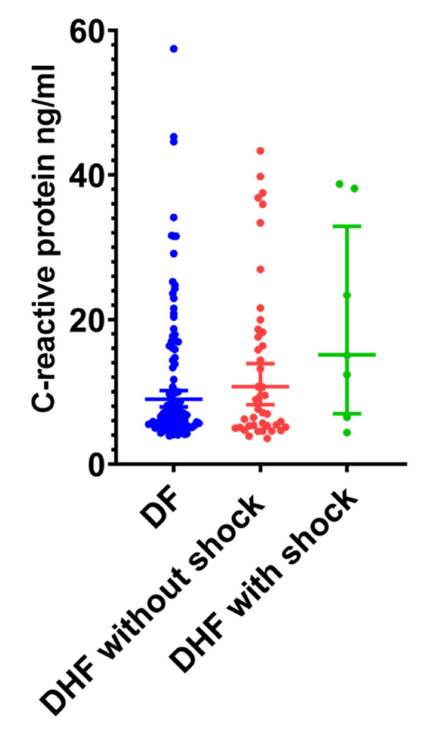
Figure 2. C-reactive protein (CRP) levels in patients with acute dengue. CRP levels were measured using the quantitative immunoturbidimetric method in patients with (A) DF ( n = 129, indicated in blue) and DHF ( n = 64, indicated in red) between day 4 and 6 of illness. Error bars indicate the median and interquartile range